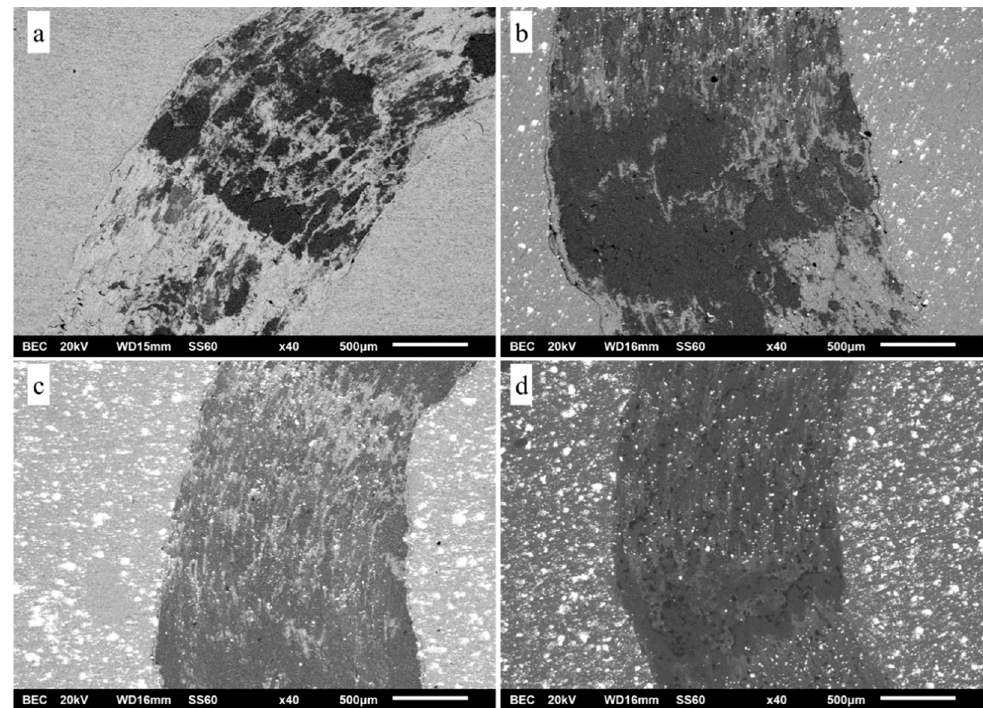
Figure 11. Wear tracks as acquired from SEM for the monolithic specimen ( a ) and for the reinforced specimens with 1 vol.% ( b ), 3 vol.% ( c ), and 5 vol.% ( d ) RHEA additions, respectively.